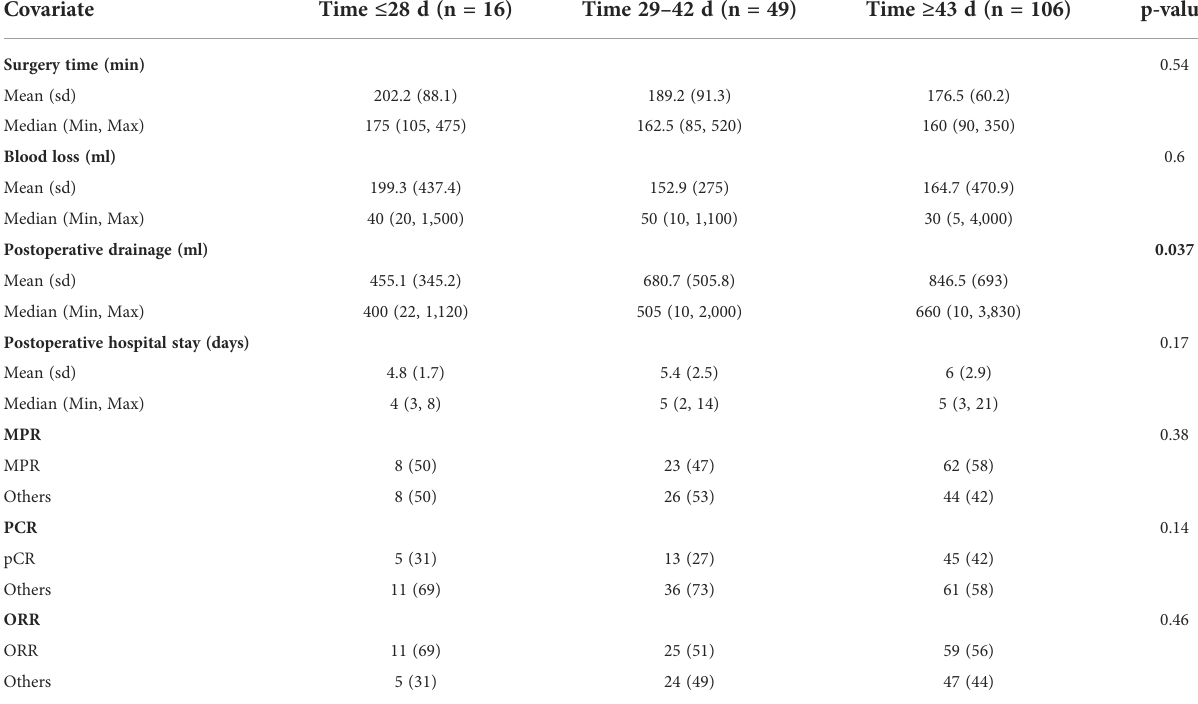
TABLE 2 Pathological and surgical outcomes of